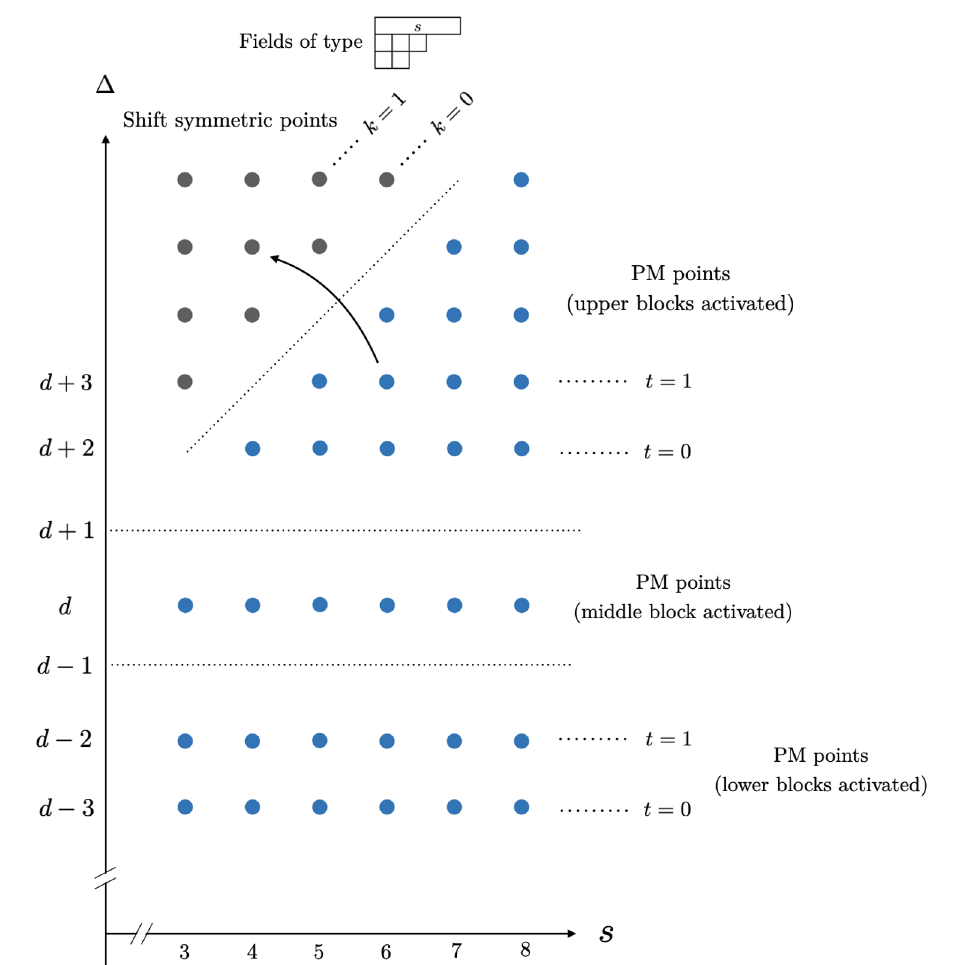
Figure 3 . Fields of symmetry type [ s, 3 , 2] in the conformal dimension ∆ vs. s plane, for the values ∆ . The masses are given by ˜ m 2 L 2 = ∆(∆ − d ) − s − 5 . Blue dots are PM points, black dots are + shift symmetric points. The shift symmetric points are the longitudinal modes of the PM points where the upper row is activated. The shift point corresponding to a given such PM point is found by reflecting about the line ∆ = s + d − 1 , as illustrated by the curved arrow. The AdS unitarity bound for each s coincides with the uppermost PM